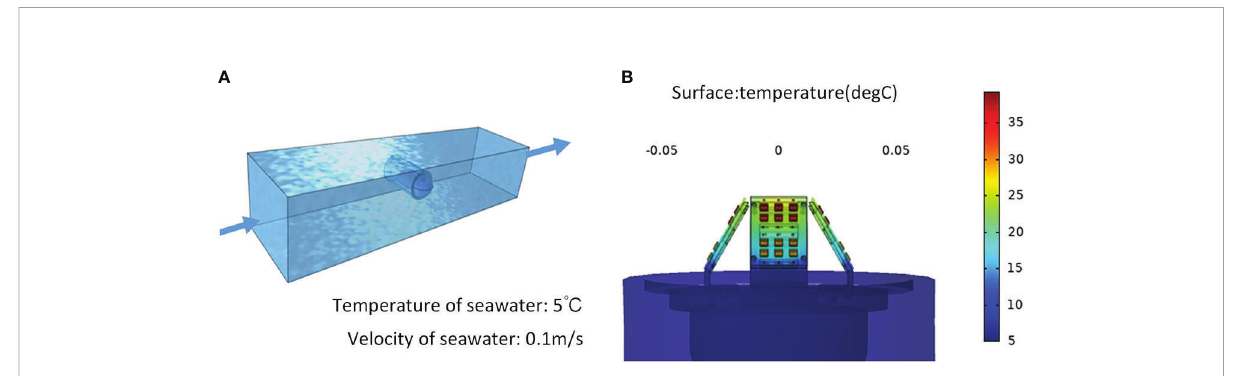
FIGURE 10 Heat dissipation simulation: (A) simulation model, (B) heat dissipation diagram of the transmitter when the thermal power is 14